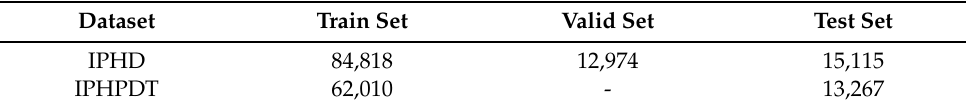
Table 2. Comparison between the IPHD dataset and our proposed IPHPDT dataset in terms of the number of images. Dataset Train Set Valid Set Test Set IPHD 84,818